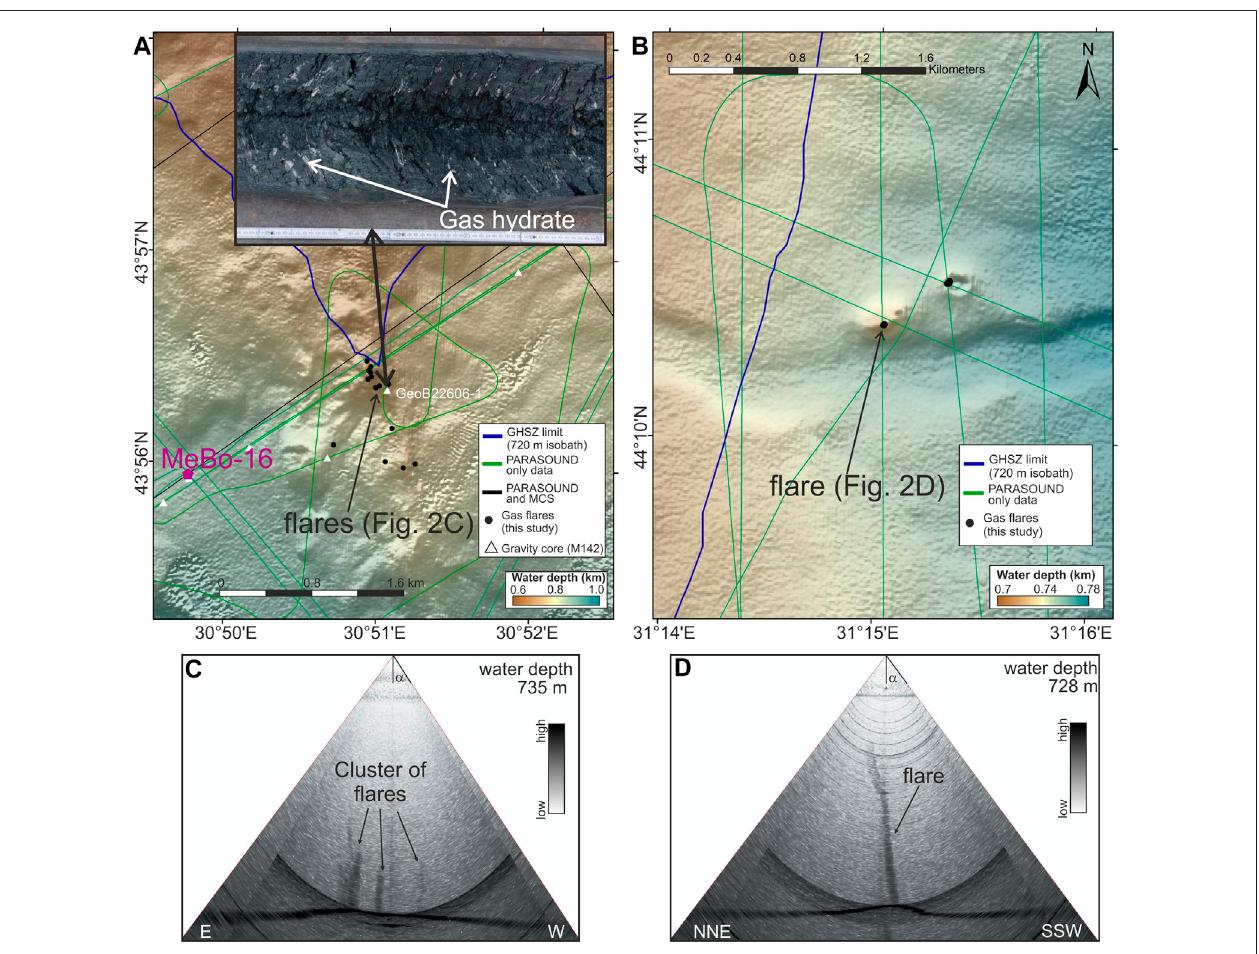
FIGURE2| ExampleoftwositeswithgashydraterecoveryinvestigatedduringM142: (A) SiteclosetodrillsiteMeBo-16withgashydraterecoveredingravitycore (station GeoB22606 – 1, inset image) and (B) site of two mud volcanoes, 500 – 800 m west of the hydrate feather edge (720 m isobath). (C,D) are examples of gas fl ares seen in the EM710 water column data. Beam-opening angle α is 60 °